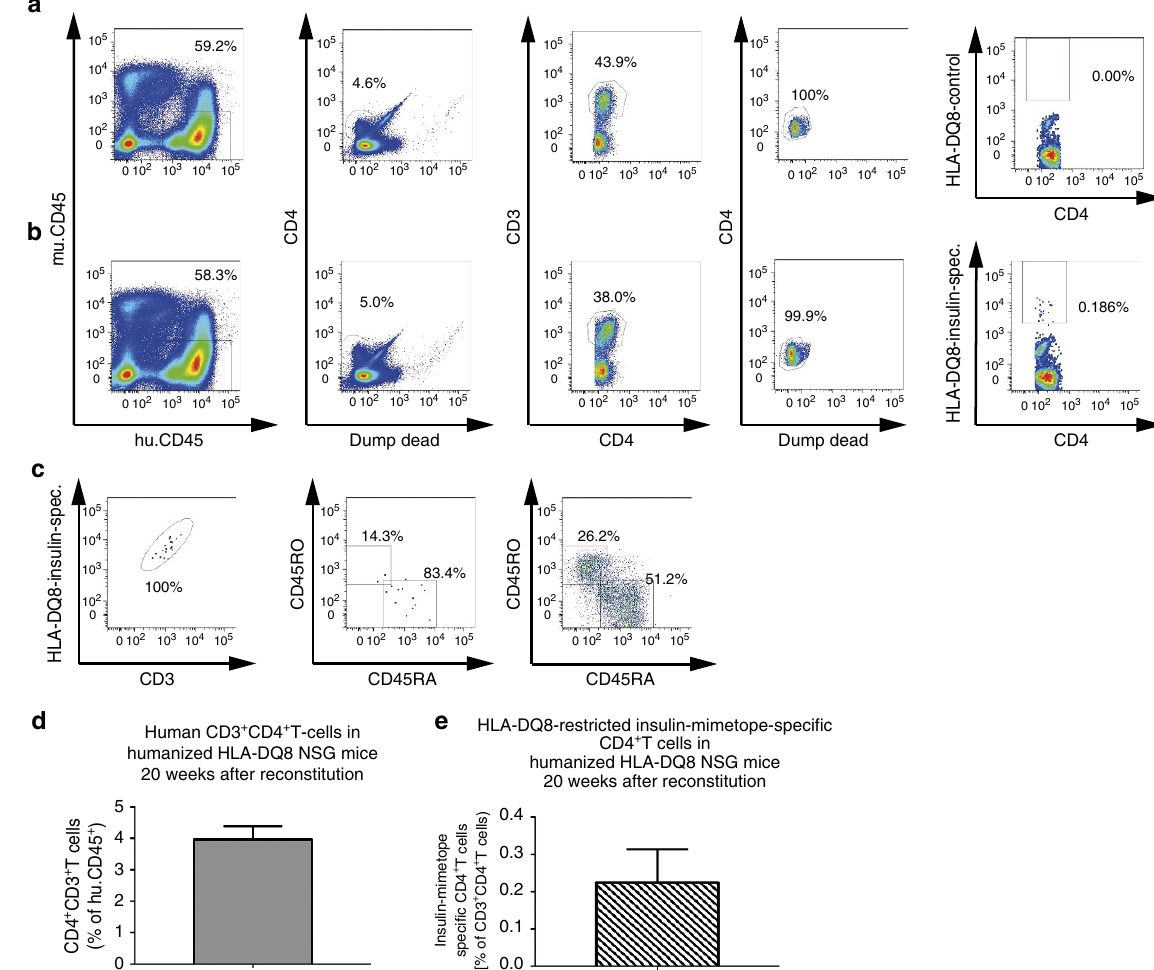
Figure 8 | CD4 þ T-cell responses in reconstituted humanized NSG-HLA-DQ8 mice. Human immune subsets purified from pooled spleen and lymph nodes of humanized NSG-HLA-DQ8 mice, 20 weeks post reconstitution, were first identified flow cytometrically based on murine versus human CD45 expression. Human CD4 þ CD3 þ T cells were characterized upon exclusion of dead cells and additional markers (CD8, CD11b, CD14, CD19). ( a-c ) Representative set of FACS plots for the identification of HLA-DQ8-restricted insulin-specific CD4 þ T cells. ( a ) Control staining to assess quality and specificity of the tetramer staining by the use of a combination of two control tetramers fused to irrelevant peptides ( a ; upper row, right plot). ( b ) Representative set of FACS plots for the identification of HLA-DQ8-restricted insulin-specific T cells gating against CD4 ( b ; lower row, right plot). ( c ) Representative set of FACS plots for the phenotypic characterization of identified HLA-DQ8-restricted insulin-specific CD4 þ T cells based on gating against CD3 and CD45RA- versus CD45RO-expression (memory-status, insulin-specific versus polyclonal). ( d ) Summary graphs for identified human CD4 þ Tcells purified from spleen and lymph nodes of respective mice, n ¼ 8 from two independent experiments. ( e ) Summary graph for identified human HLA-DQ8-restricted insulin-specific CD4 þ T cells purified from spleen and lymph nodes, n ¼ 8 from two independent T1D patients harbouring DQ8 or DQ2 alleles. HLA-DQ8 shares with I-A g7 strikingly similar binding pockets for peptide presentation 29 . Insulin B:9-23-reactive CD4 þ T cells are present in the peripheral blood of T1D individuals, the immunogenic register of this peptide has low-affinity binding to HLA-DQ8 (ref. 30) and a strong agonistic variant of the natural insulin epitope established in the murine system 7 can efficiently stimulate human CD4 þ T cells 31 .